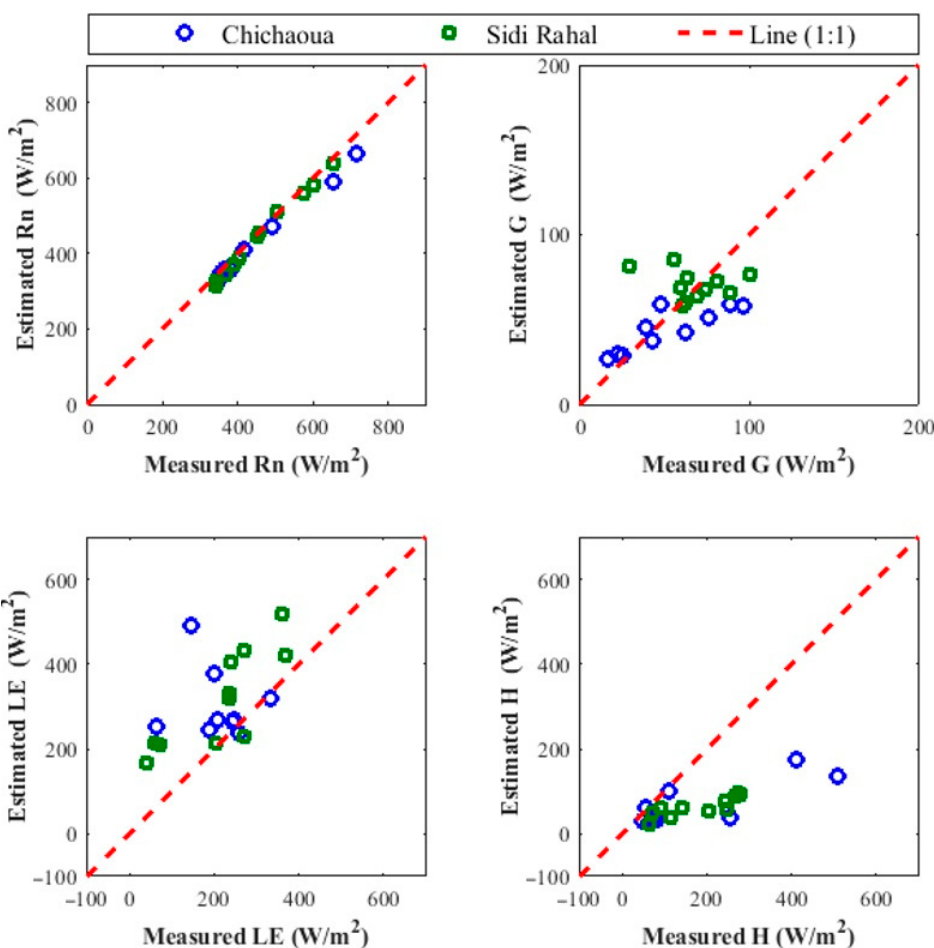
Figure 4. Scatterplot of simulated versus observed Rn, G, LE, and H using the TSEB model at the Chichaoua and Sidi Rahal sites. Table 2. Statistical results (RMSE, R 2 , and MBE) between the modeled and measured net radiation,